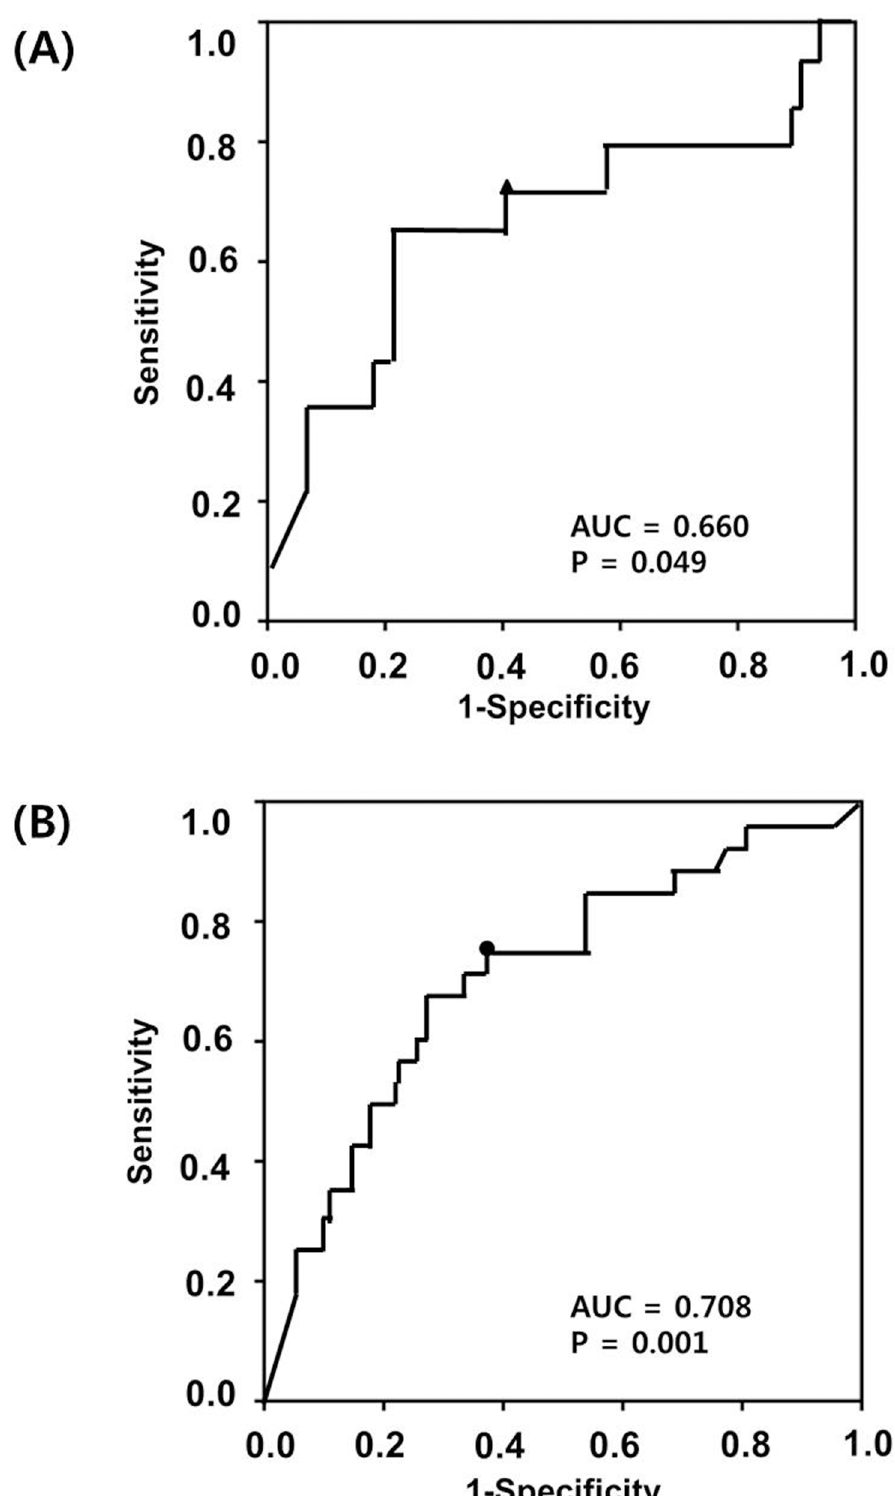
Fig 1. Receiver-operating characteristic curves for vitamin D-binding protein in the cervicovaginal fluid in the prediction of (A) intra-amniotic infection (area under the curve [AUC] 0.660, SE 0.092, P = 0.049), and (B) imminent preterm delivery within 48 hours (AUC 0.708, SE 0.056, P = 0.001) in women with preterm labor and intact membranes. https://doi.org/10.1371/journal.pone.0198842.g001 PLOS ONE | https://doi.org/10.1371/journal.pone.0198842 June 7,